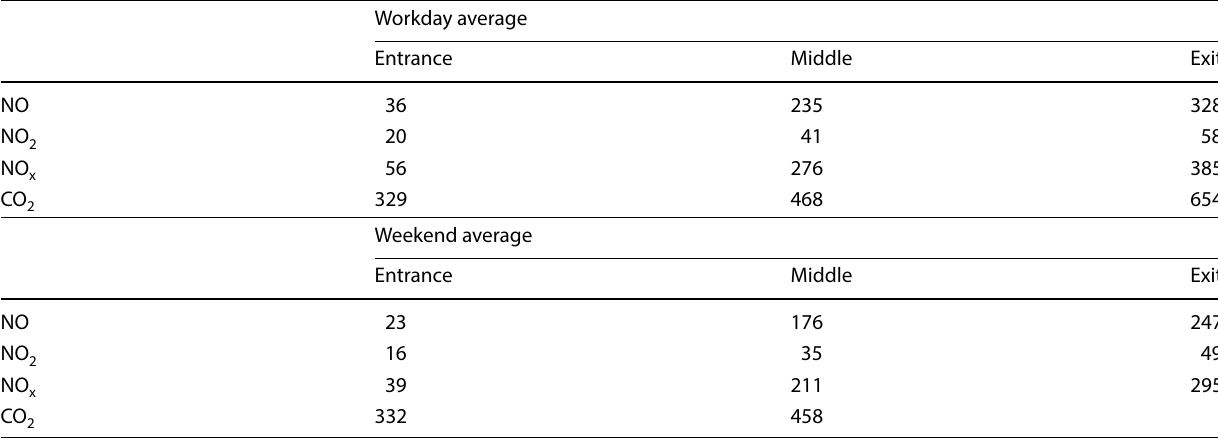
Concentrations of every pollutant rose over the tunnel length. All data is given in ppb units